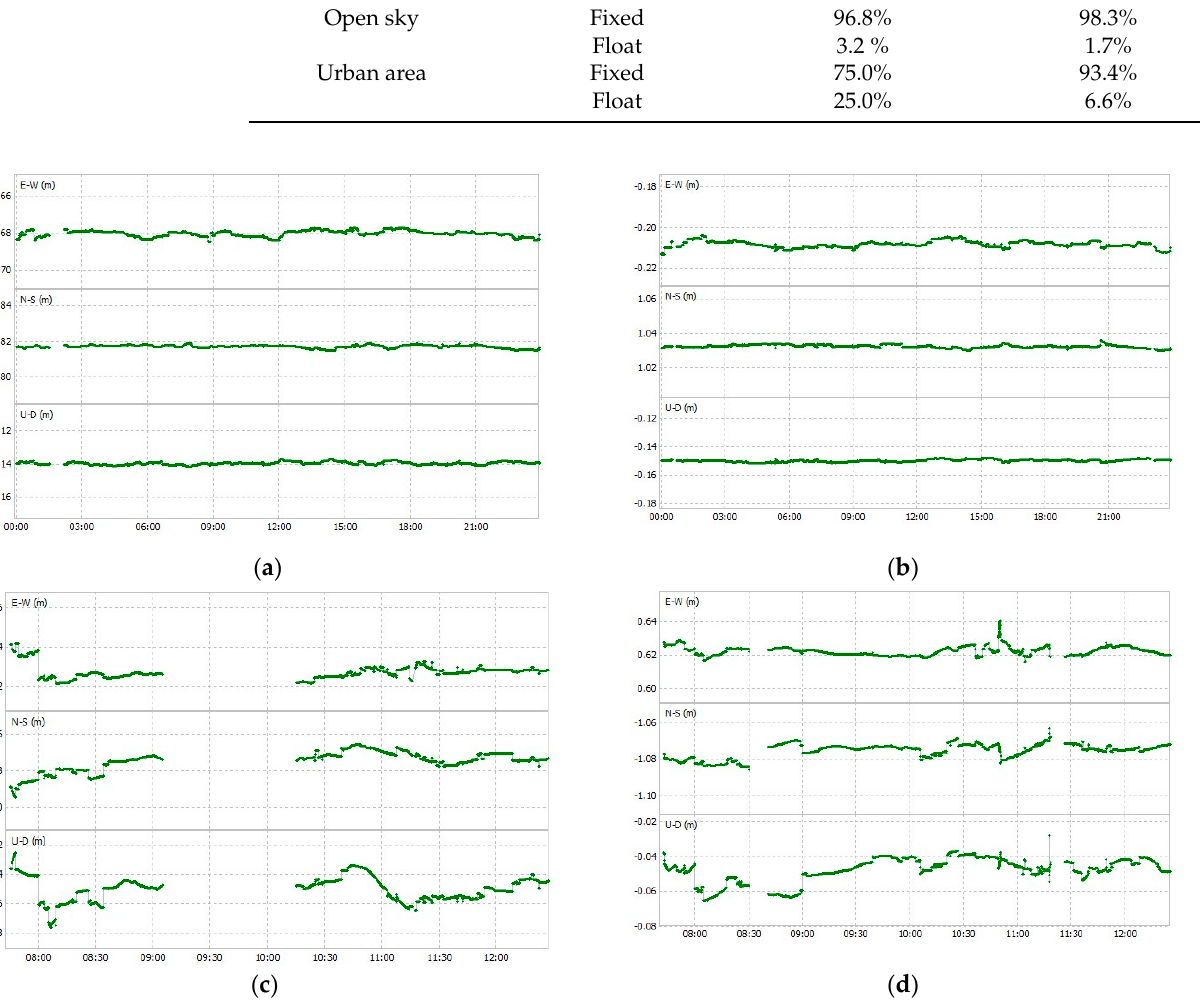
Figure 9. Positioning solutions in open sky and urban conditions: ( a ) LC − 1 on ST 1 (open sky); ( b ) LC − 2 on ST 1 (open sky); ( c ) LC − 1 on ST 1A (urban areas); and ( d ) LC − 2 on ST 1A (urban areas).